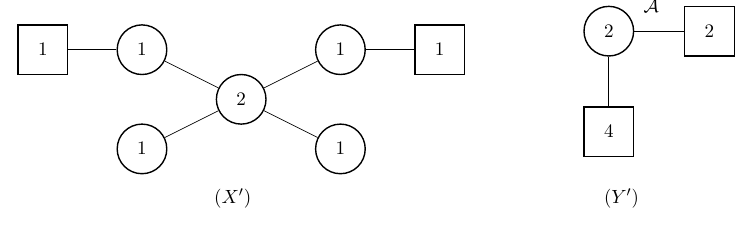
Figure 47 . 3d mirror of an affine D 4